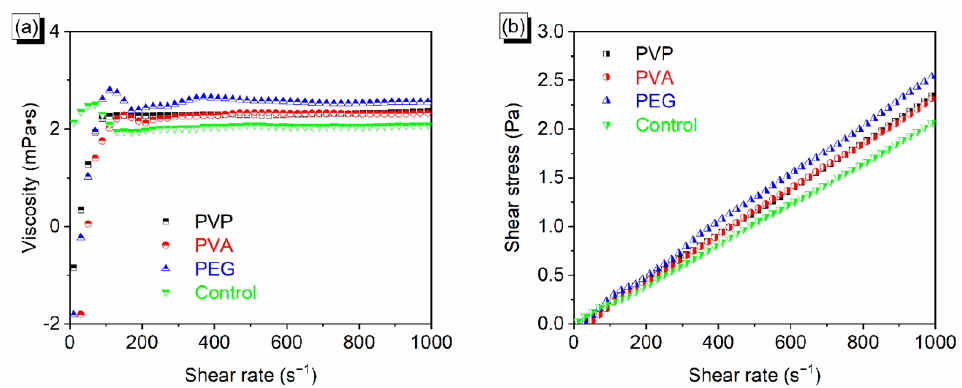
Figure 1. ( a ) Correlation between shear rate and viscosity of inks with different additives, and ( b ) correlation between shear rate and shear stress.